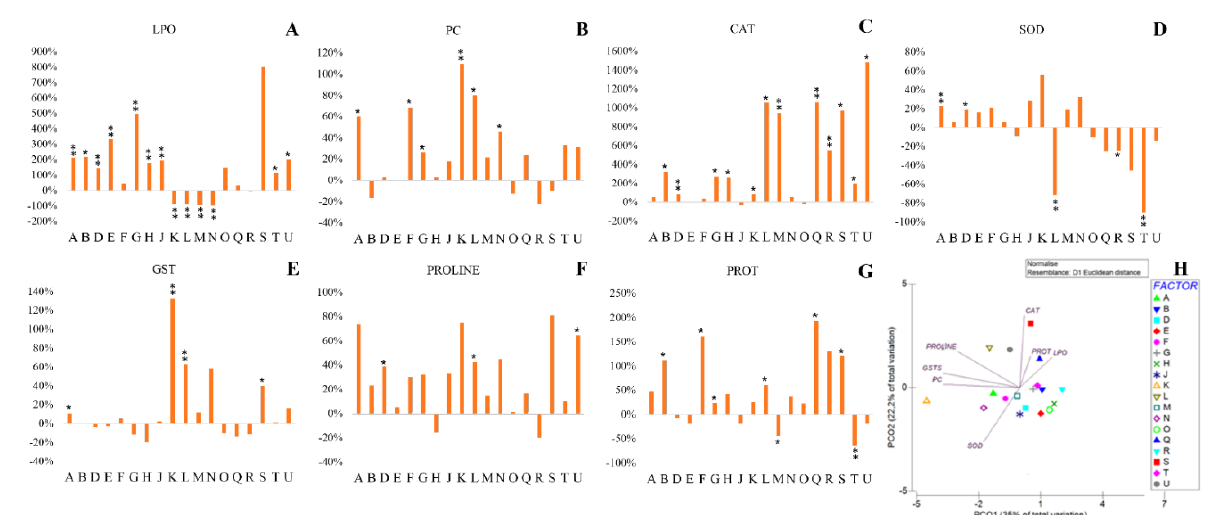
Figure 1. Biochemical parameters evaluated in rhizobacteria isolated from plants grown in Cabo Verde: ( A ) Lipid peroxidation, ( B ) Protein carbonylation, ( C ) Catalase, ( D ) Superoxide Dismutase, ( E ) Glutathione S-Transferase, ( F ) Proline, ( G ) Protein, ( H ) principal coordinates ordination of bio- chemical parameters under drought stress. Biochemical markers variation of bacterial cells exposed to PEG50 relatively to control (not exposed to PEG). Bacterial strains: Pantoea spp. (A); Klebsiella spp. (B); Pseudomonas spp. (D); Pseudomonas spp. (E); Acinetobacter spp. (F); Stenotrophomonas spp. (G); Enterobacter spp. (H); Enterobacter spp. (J); Pantoea spp. (K); Pseudomonas spp. (L); Rhizobium spp. (M); Paenarthrobacter spp. (N); Ochrobactrum spp. (O); Pseudomonas spp. (Q); Rhizobium spp. (R); Stenotrophomonas spp. (S); Pseudomonas spp. (T); Enterobacter spp. (U). Values are means of three replicates + standard deviation. Significant differences compared to non-inoculated watered plants (control) were marked with single asterisks ( p < 0.05) or double asterisks ( p < 0.01). For additional information (means, standard deviation and statistical significance) see supplementary Table